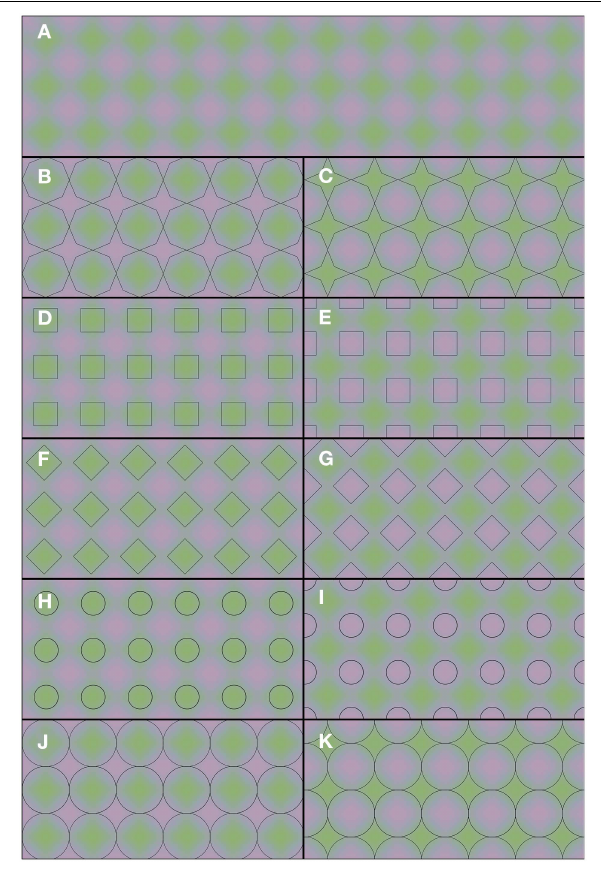
and each contour version of Figure 2 vs. its counter phase alternative ( Figure 2B vs. Figure 2C , Figure 2D vs. Figure 2E , Figure 2F vs. Figure 2G , Figure 2H vs. Figure 2I , and Figure 2 J vs. Figure 2K ). All comparisons were randomized and repeated 4 times for each observer. The observer’s viewing distance was approximately 40 cm and his/her task was to indicate whether the colors of the left display and the right display were the same